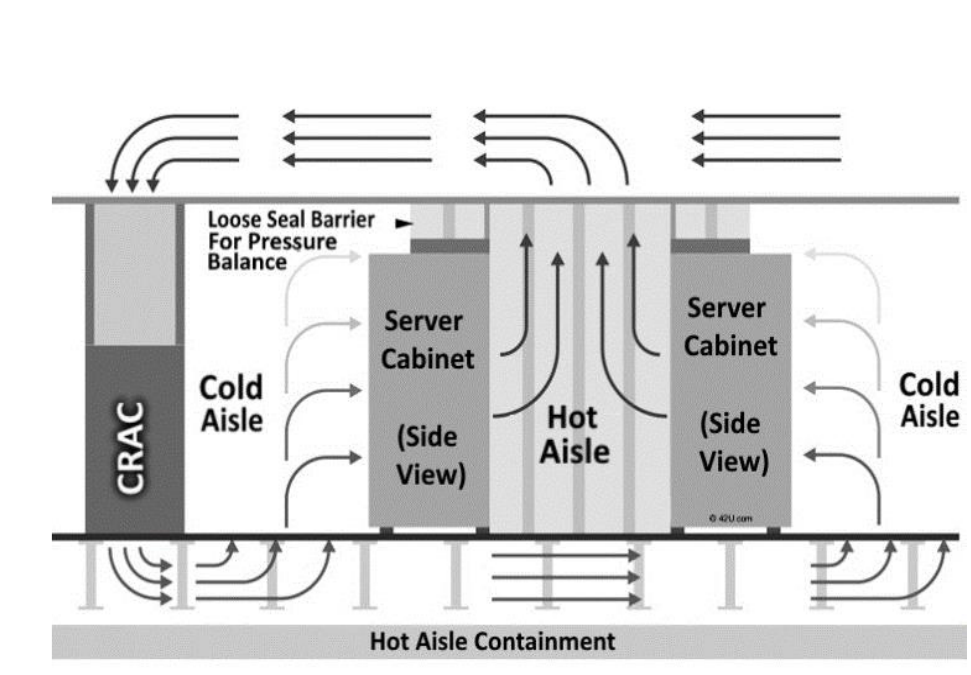
Figure 1. Hot & cold aisle data center